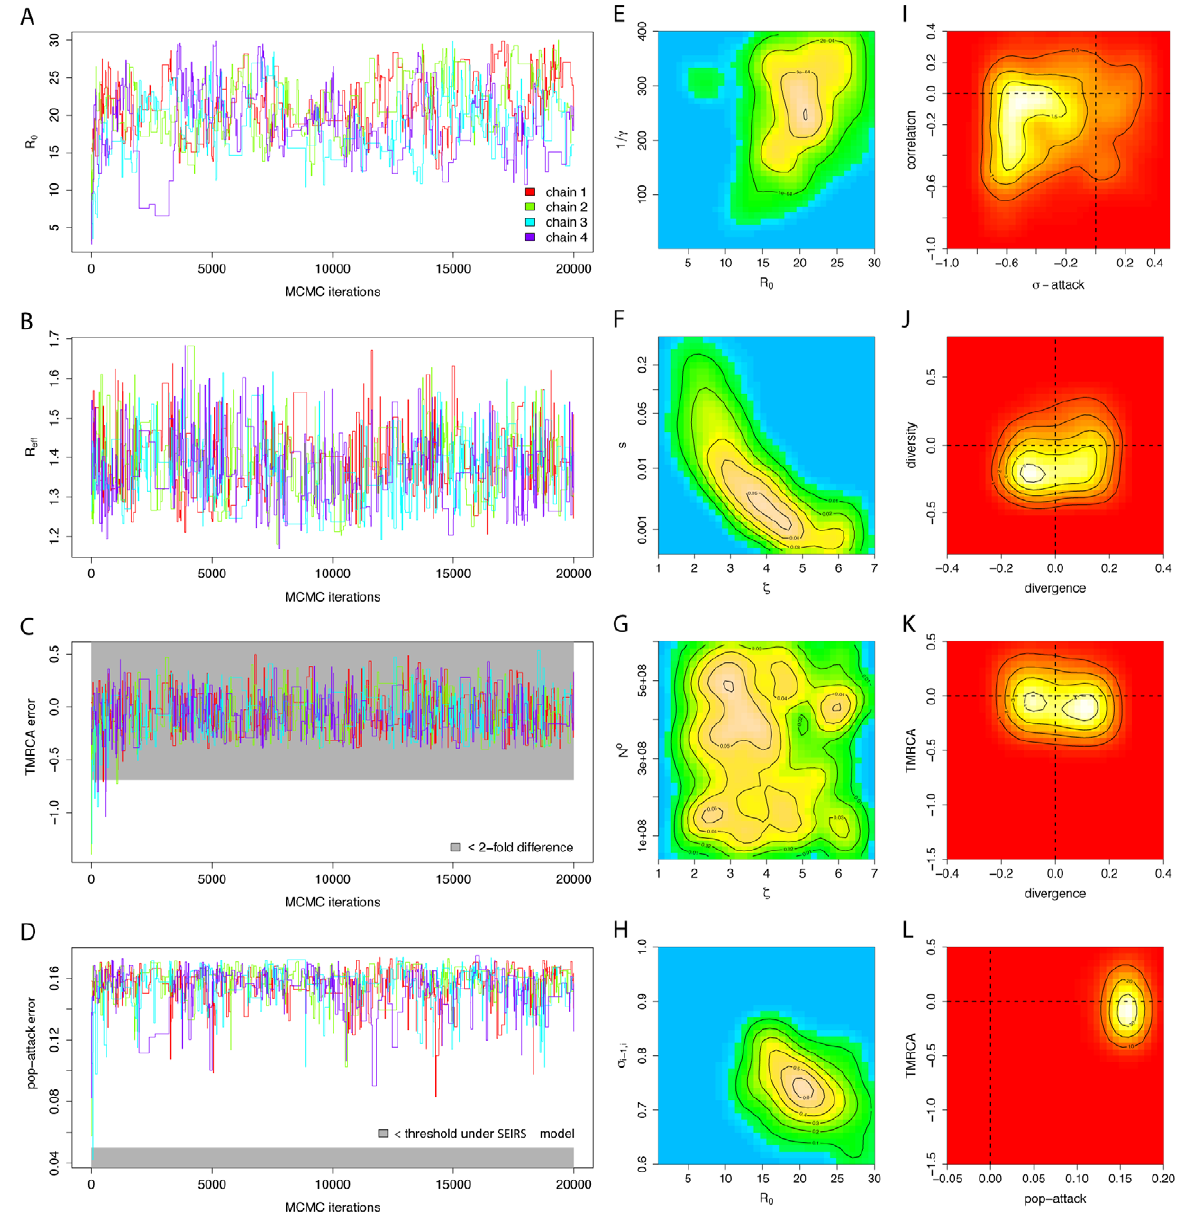
Figure 5. Phylodynamic inference and goodness-of-fit analysis of the spatial epochal evolution model. (A–D) MCMC trajectories as in Figure 3. The summaries TMRCA and pop-attack are in conflict and cannot be simultaneously fitted, so that the tolerance for pop-attack was relaxed. Samples before iteration 5000 were discarded. (E–H) Two-dimensional histograms of parts of the ABC fit as in Figure 3. Partial cross-immunity is relatively low and correlates negatively with R 0 . (I–L) Two-dimensional histograms of parts of the joint density of summary errors as in Figure 3. The epochal evolution model captures the irregularity in H3N2 case report attack rates, and the divergence, diversity and narrowness of the HA phylogeny well, albeit at a high residual selection parameter that is essentially always included. However, under this fitted model, population-level attack rates are in conflict with the TMRCA ’s and cannot be simultaneously reproduced when Q (cid:2) is weak.